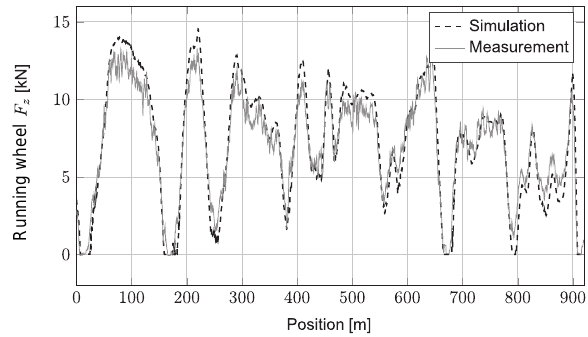
Figure 14. Normal force F z on a running wheel: measurement and